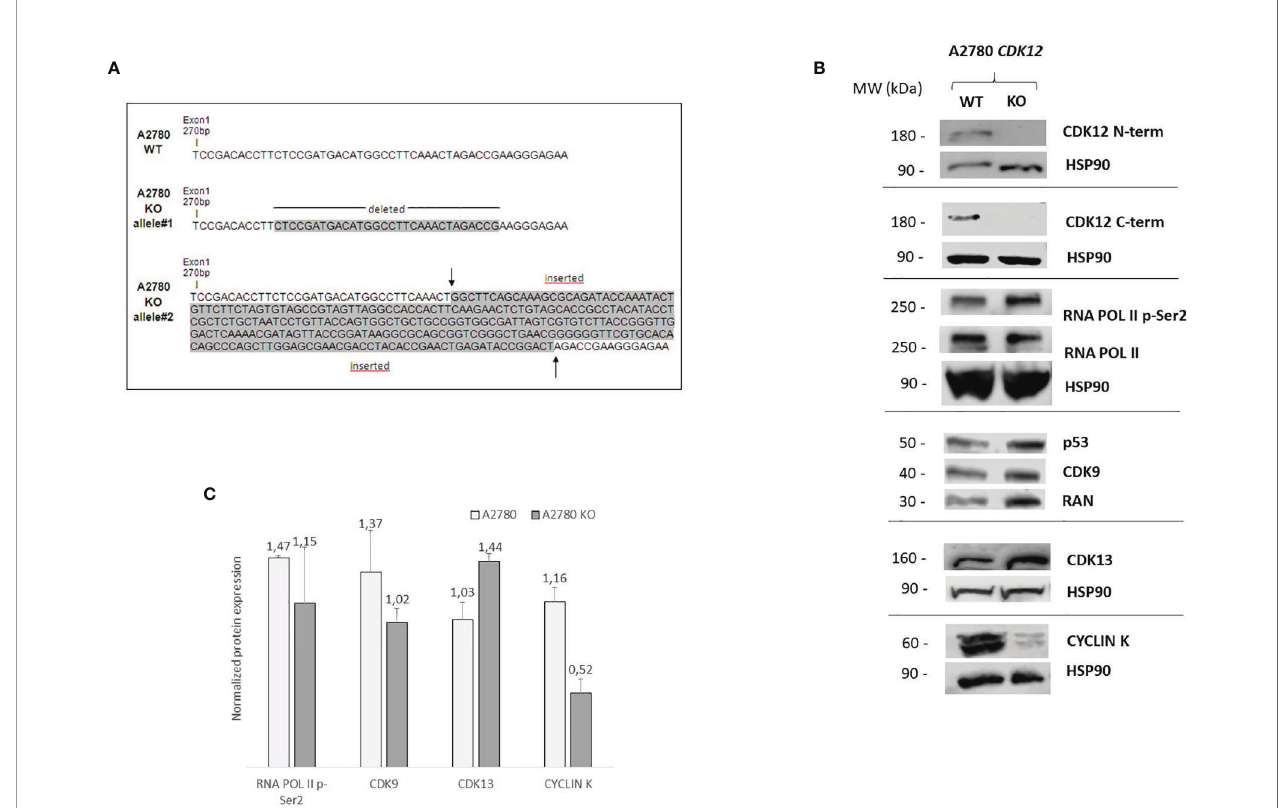
FIGURE 1 | Molecular characterization of A2780 and A2780 CDK12 KO cells. (A) Nucleotide sequences of the loci targeted by CRISPR/Cas9 in exon 1 of CDK12 , generating CDK12 KO clones. Upper panel: nucleotide sequences of A2780 CDK12 WT and KO; shaded nucleotides were deleted and inserted in KO clone allele #1 and #2, respectively. (B) Western blot analysis showing CDK12 , HSP90, RNA pol II p-Ser2, RNA pol II, p53, CDK9, cyclin K, CDK13, RAN protein levels in A2780 and A2780 CDK12 KO cell lines. All the protein blots for western analysis have been cropped before antibody hybridization to be able to detect in the same fi lter different proteins. (C) Quanti fi cation of the western blot data by densitometric analyses. Values are normalized by actin and are the mean+SD of three